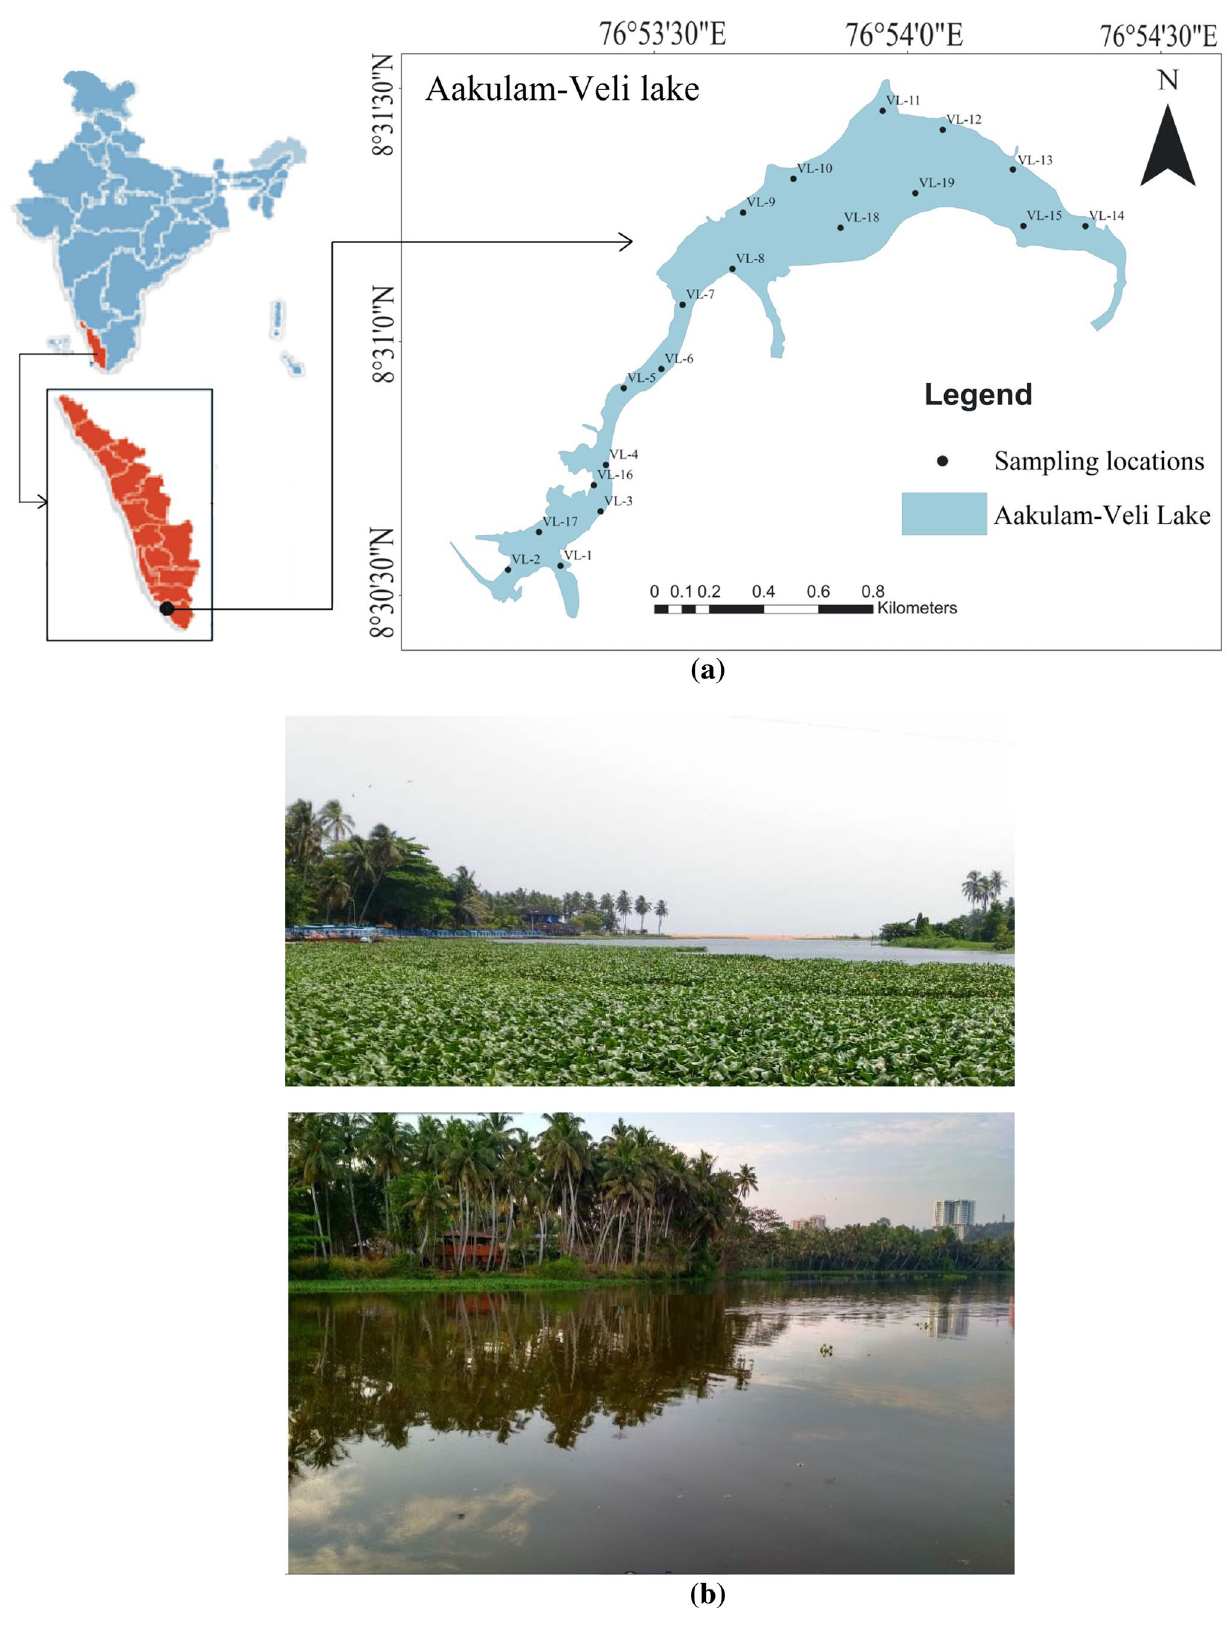
Fig. 1 a Location map of the study area. b Photographs of the Akkulam-Veli